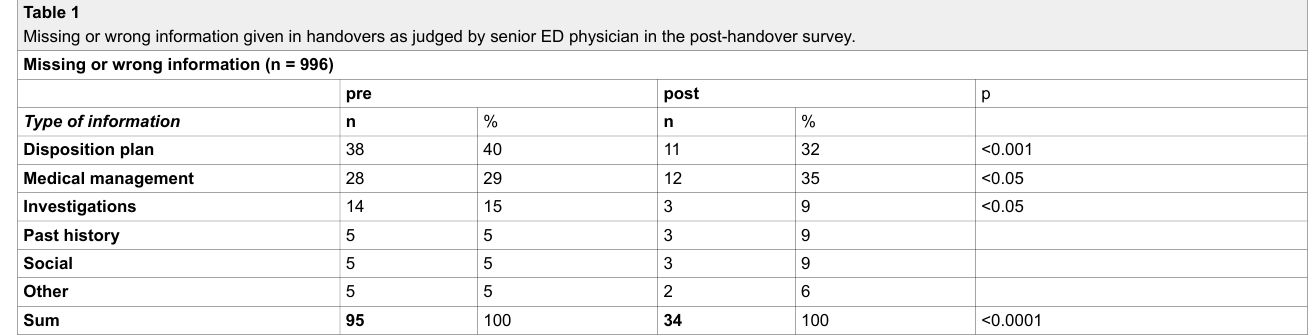
Handover quality before (pre) and after (post) “dINAMO” Numbers in bars depict mean value (panel A & D) or total events (panel B & C). Bars represent S.E.M where present. Significance calculated by t-test. Panel A: Handover time per patient. Mean time required for handover declined from 98 before the intervention to 72 seconds after the intervention. Panel B: Wrong/missing information. Handover informational items missing or wrong judged by the senior ED physician after ward rounds. Panel C: Consequences of wrong/missing information. Preventable adverse events secondary to missing or wrong items during the handover, judged by the senior ED physician after ward rounds. Panel D: Quality of handover. After the ward rounds the senior ED physician rated the quality of the previous handover on a 7 point scale: 1 = very bad, 2 = bad, 3 = rather bad, 4 = neutral, 5 = rather good, 6 = good, and 7 = very good. The rating did not significantly differ between the two groups (n.s.).